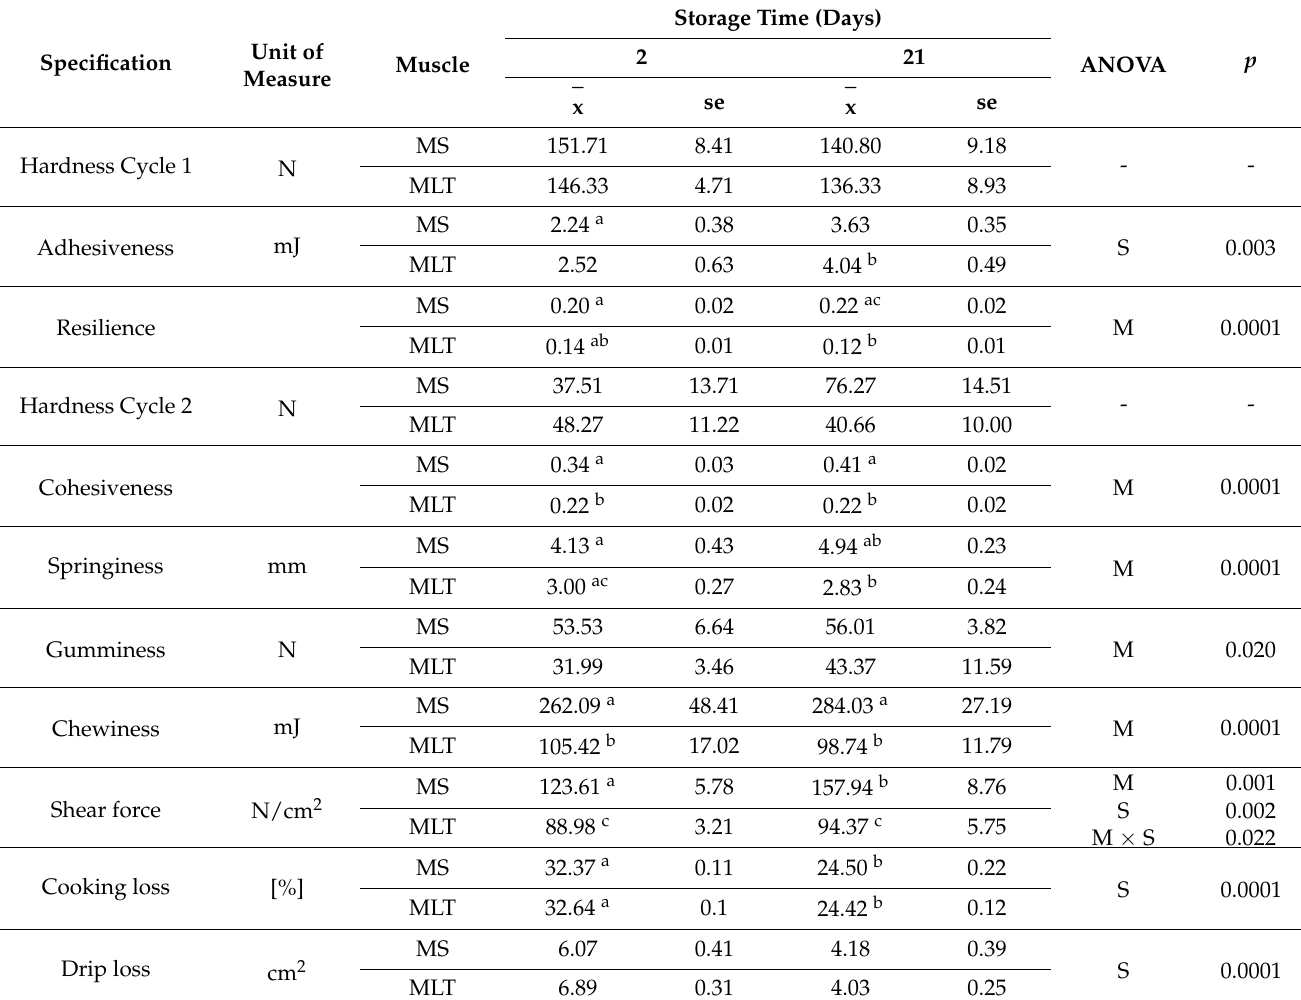
Table 1. Texture parameters and hydration properties of raw beef as a function of muscle type and cold storage